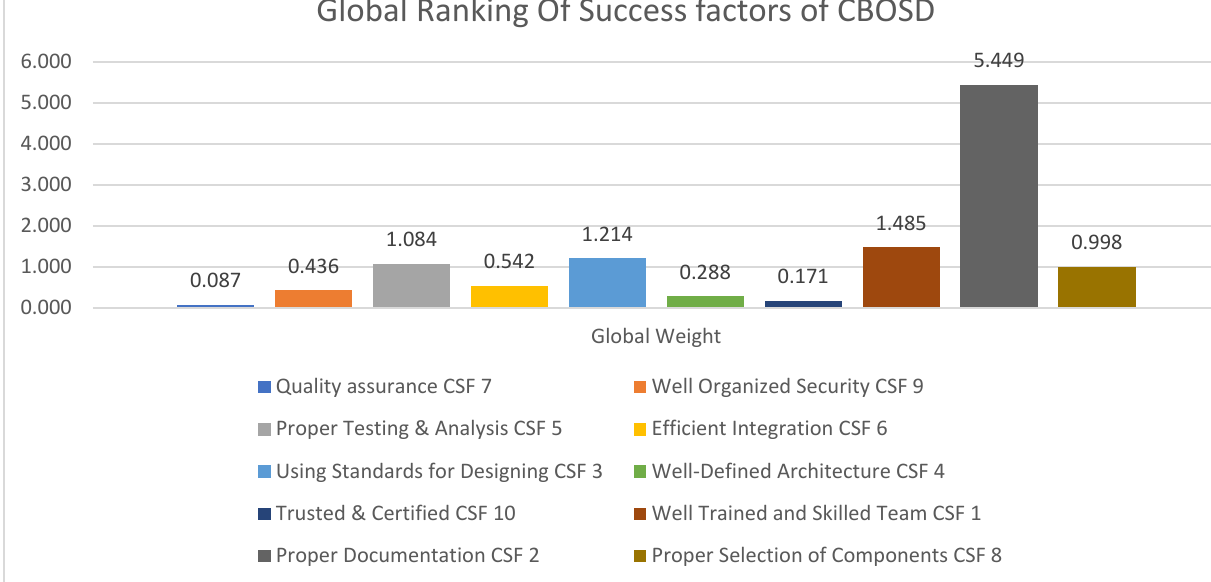
Figure 3. Local and global weight comparison of the success factors.